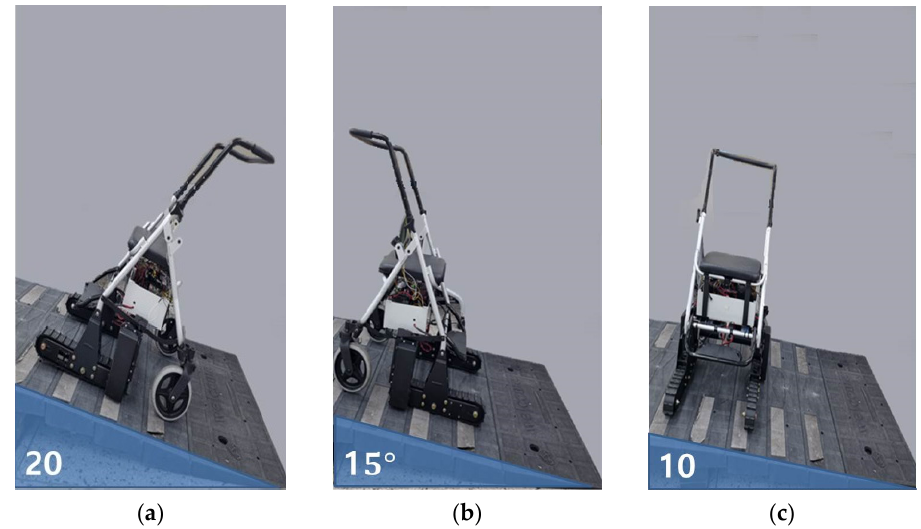
Figure 8. ( a ) Forward stability test; ( b ) backward stability test; ( c ) sideways stability test.